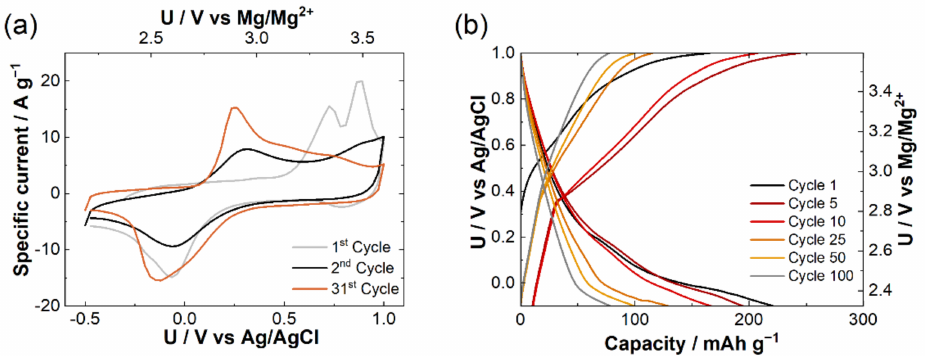
Figure 1. ( a ) Cyclic voltammograms of LiMn 2 O 4 in 0.1 M aqueous solution of Mg(NO 3 ) 2 and ( b ) galvanostatic cycling at C/4 rate in 1 M aqueous solution of Mg(NO 3 ) 2